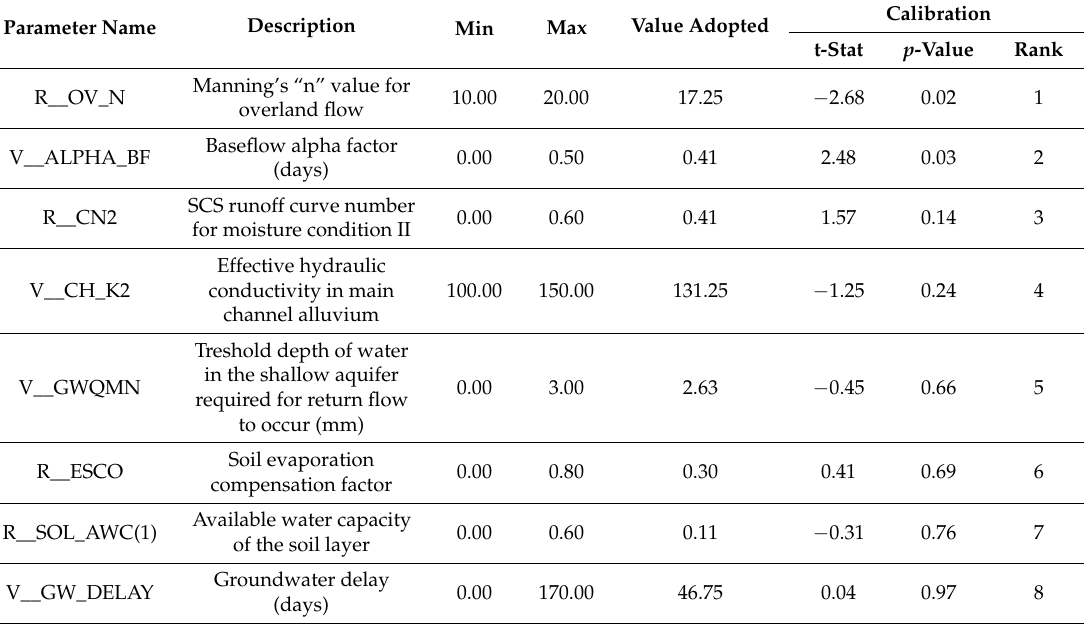
Table 2. Ranking of the most sensitive parameters and their monthly simulation variation ranges.